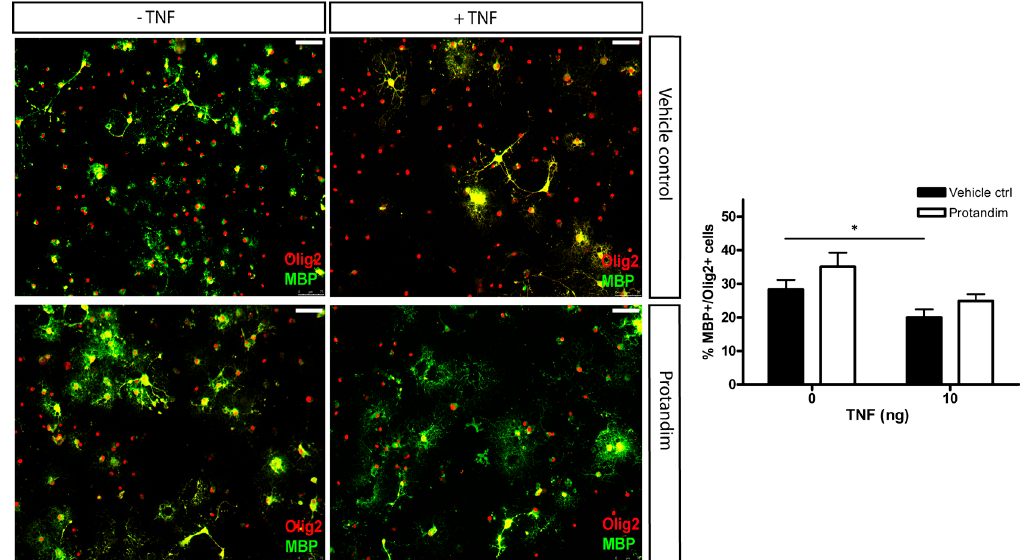
Figure 8. Protandim marginally promotes differentiation of primary rat OPCs in the presence of TNF. After 2 days of de-differentiation, primary rat OPCs were incubated with 30 μ g/mL Protandim or vehicle control (EtOH) for 24 h. After removal of medium, cells were subsequently exposed to either control medium or medium with 10 ng/mL TNF for 5 days. MBP and Olig2 expression were assayed by immunocytochemistry. Data are presented as percentage of control and expressed as the mean ± SEM of 3 independent experiments. Statistics reflect student’s t -test, one-tailed; * p < 0.05.